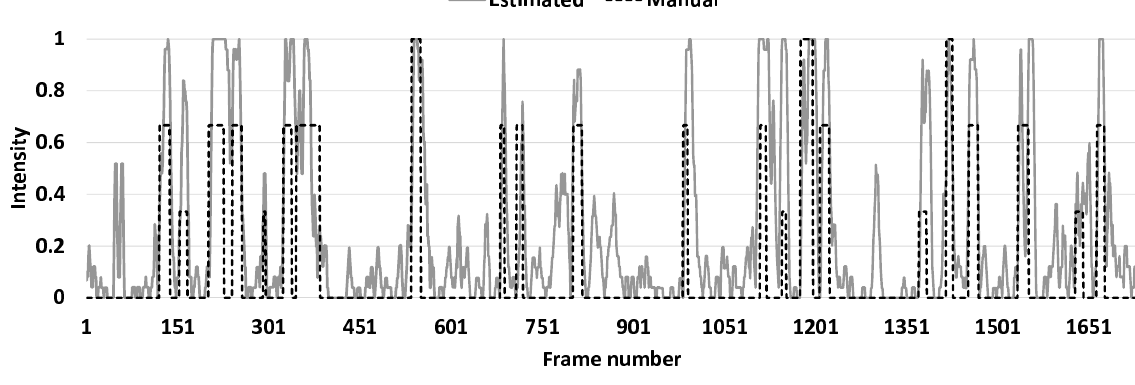
Figure 7: The facial expression intensity estimated for video clip